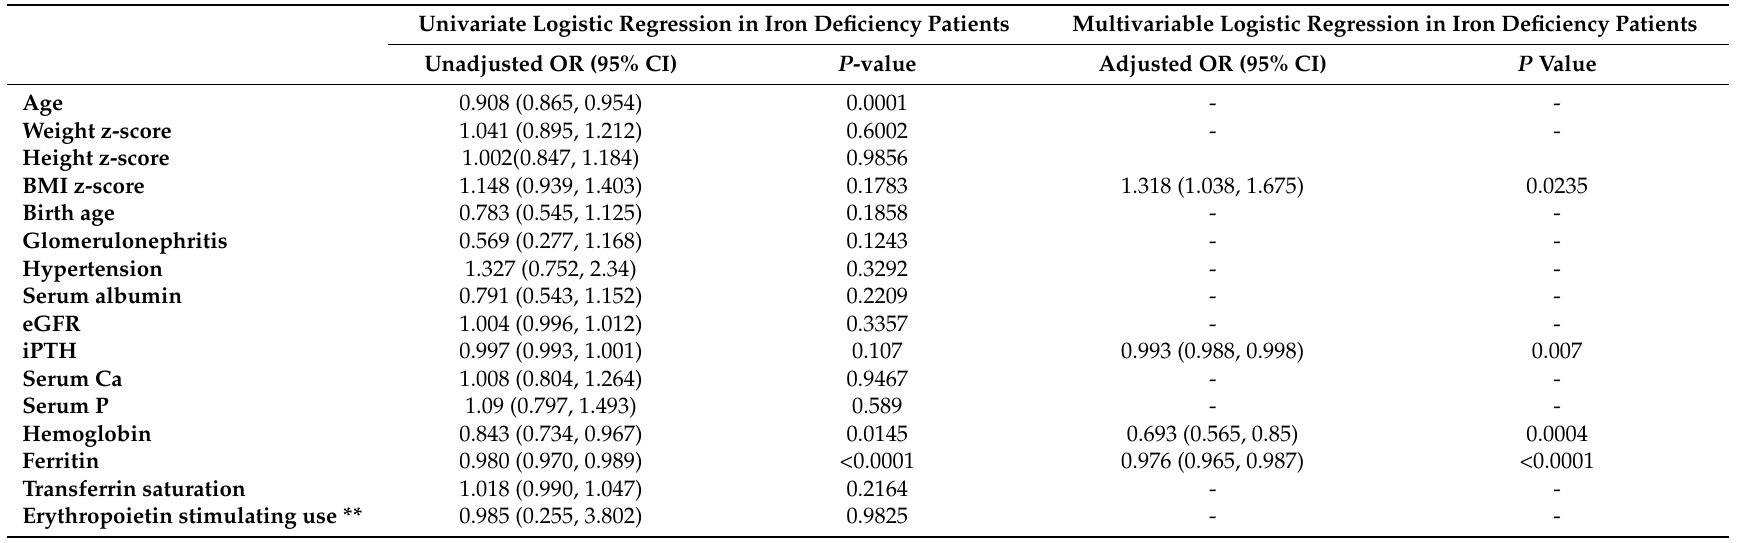
Table 9. Associated risk factors for iron deficiency in patients with CKD who did not take iron supplements. Univariate Logistic Regression in Iron Deficiency Patients Multivariable Logistic Regression in Iron Deficiency